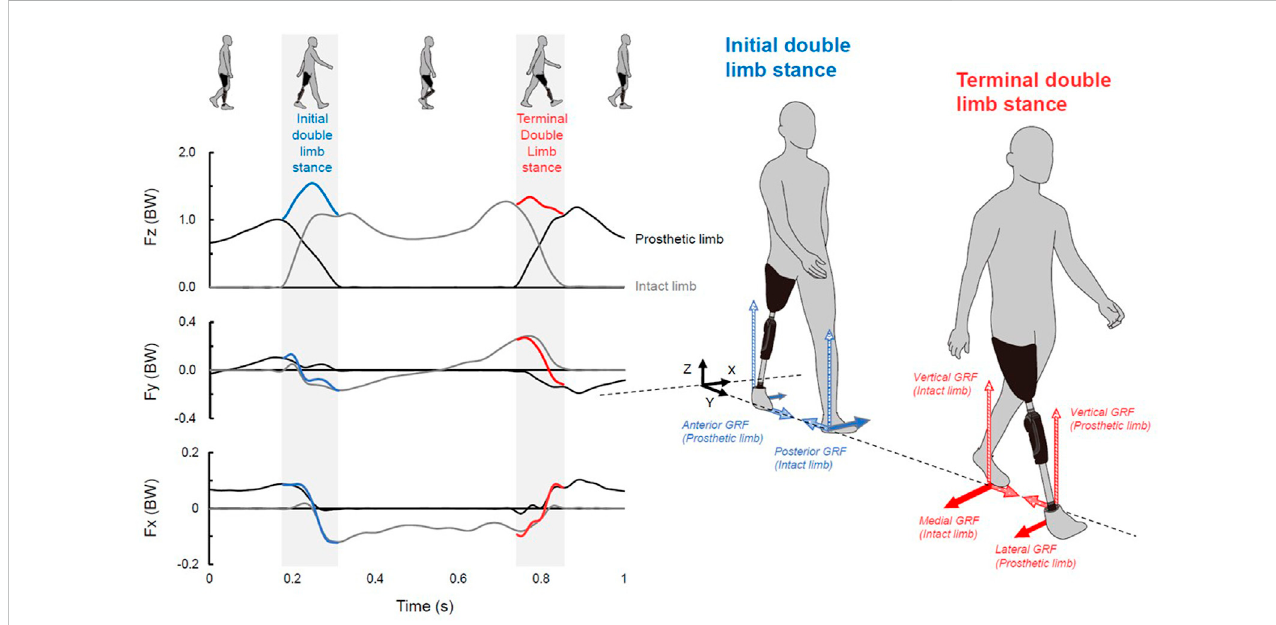
FIGURE 1 Left: vertical (Fz), anteroposterior (Fy), and mediolateral (Fx) ground reaction forces (GRFs) from the perspective of the leading limb normalized to the body weight (BW). GRFswererecordedfrom one representativetrial ofan individuals with uTFAduring walking at 4.5 km/h. Bold blueand red curves indicate the sum of the GRF of the initial and terminal double limb stance in each component, respectively. Right: de fi nition of each GRF component at initial and terminal double limb